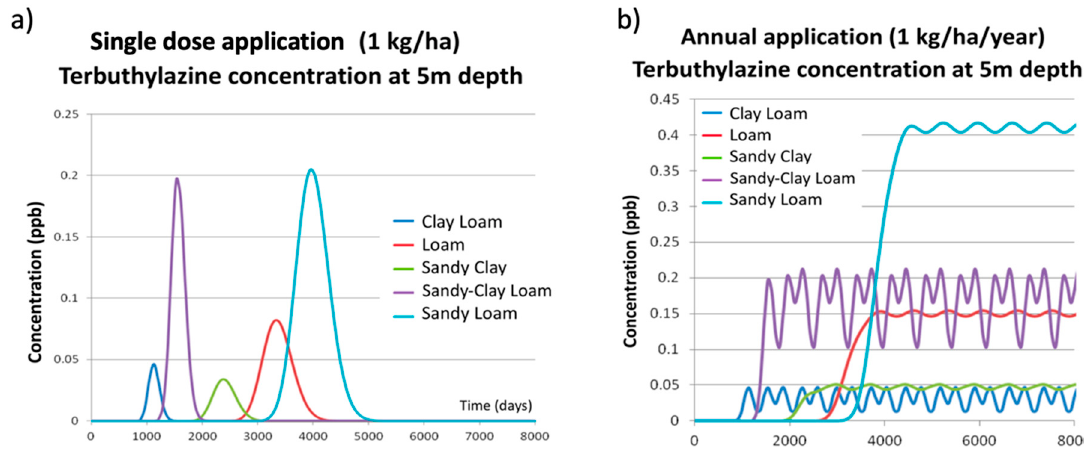
Figure 4. PESTAN terbuthylazine concentrations at 5 m depth for di ff erent types of soil. ( a ) Single dose application. ( b ) Annual application.